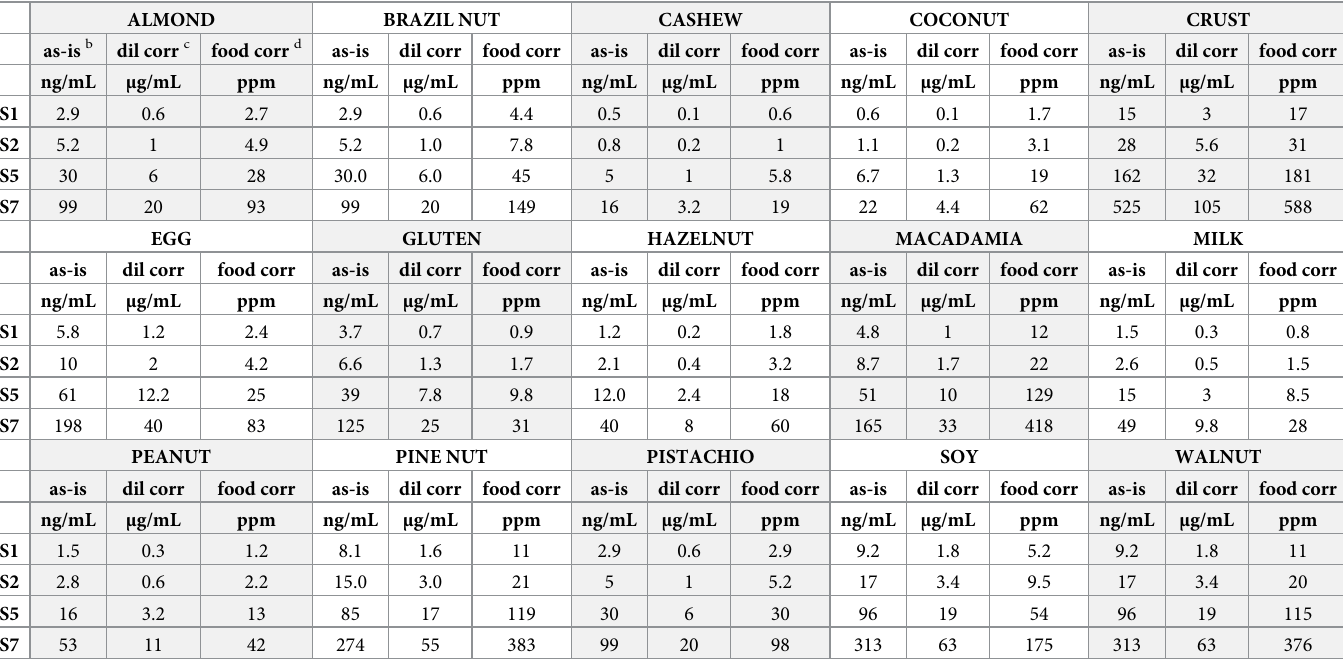
Table 1. Calibration standards for buffered-detergent analyses & equivalence in food units a . ALMOND BRAZIL NUT CASHEW